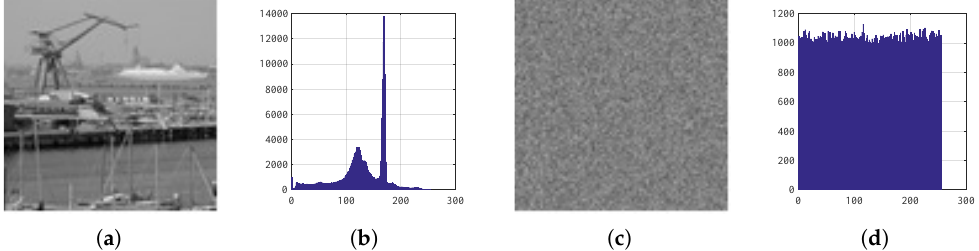
Figure 13. Histograms: ( a ) Kiel image, ( b ) histogram of plain Kiel, ( c ) encrypted Kiel, and ( d ) his- togram of encrypted Kiel.